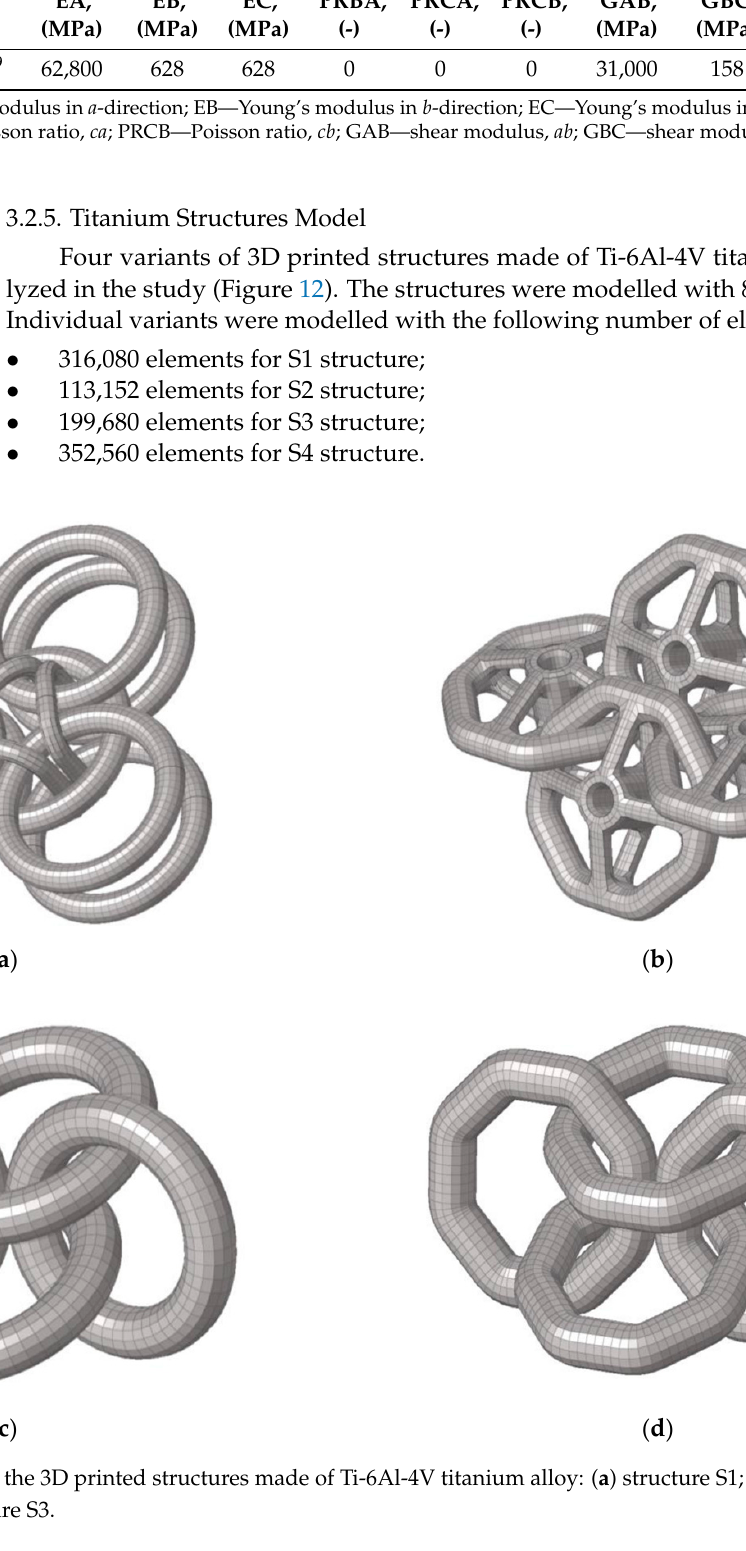
Table 4. Parameters of the *MAT_002-OTHOTROPIC_ELASTIC model for Twaron CT 750 fabric. Specification